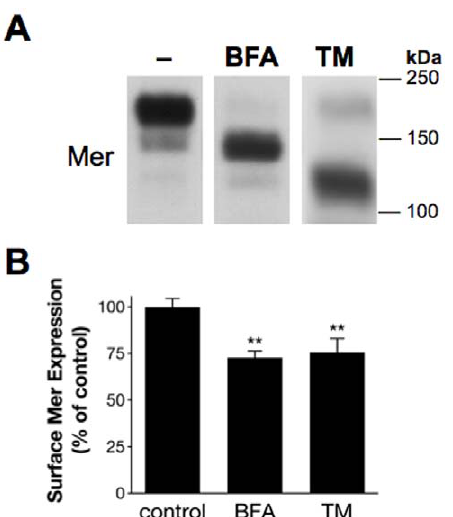
Figure 4. Reduced surface expression of Mer results from incomplete glycosylation. Jurkat cells were cultured in the presence of 5 m g/ml Brefeldin A (BFA), 1 m g/ml TM, or 0.1% DMSO vehicle control ( 2 ) for 24 hours. ( A ) Western blot detection of Mer from whole-cell lysates. ( B ) Surface expression of Mer was measured by flow cytometry, and MFIs from BFA- and TM-treated samples were normalized to control MFI for each experiment. Mean values and SD derived from 3 independent experiments are shown (** p , 0.005, 1-way repeated measures ANOVA followed by Bonferroni post-tests).